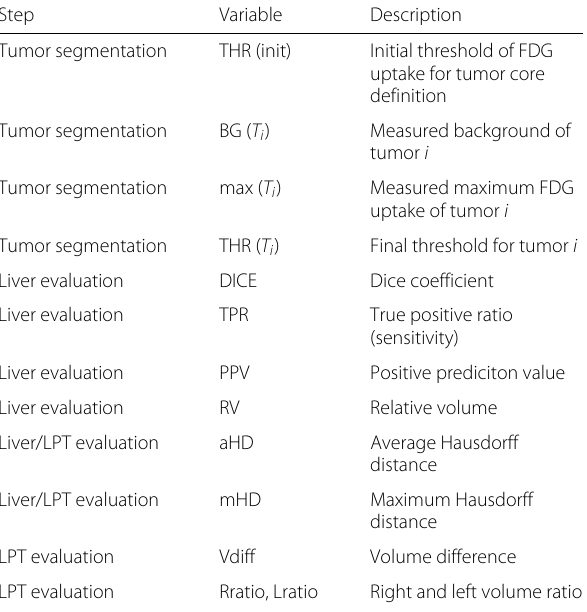
Table 1 List of variables that are used in VOI segmentation and validation